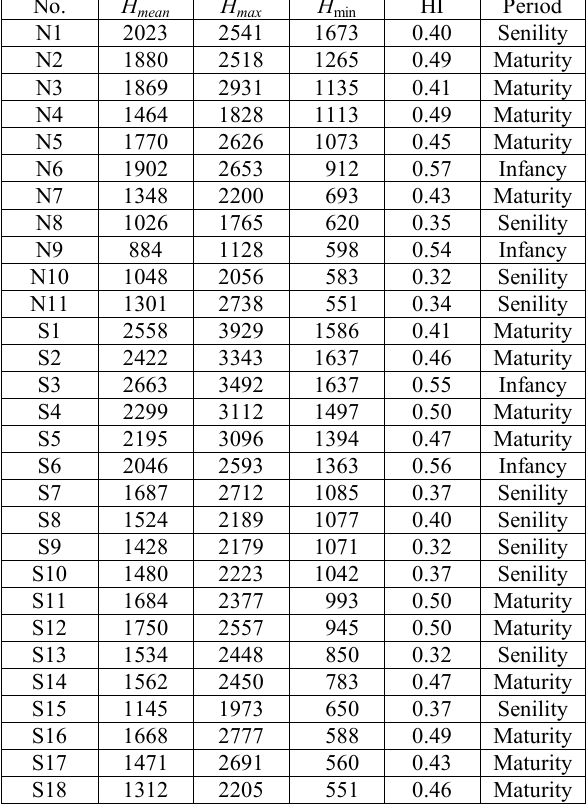
Table 2. The HI values for each sub-basin